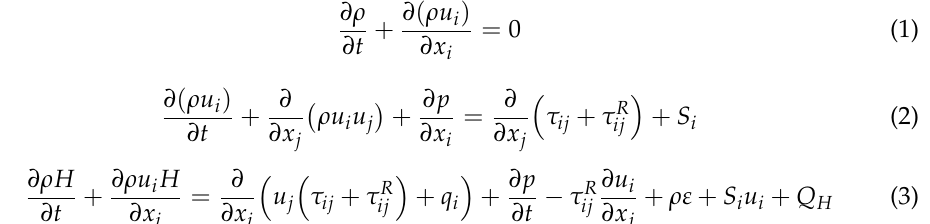
Total Weight [kg]